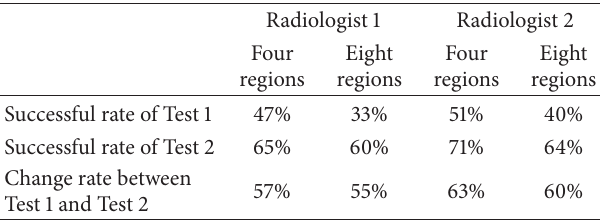
Table 4: Effectiveness of acute ischemic stroke detection in images with four brain